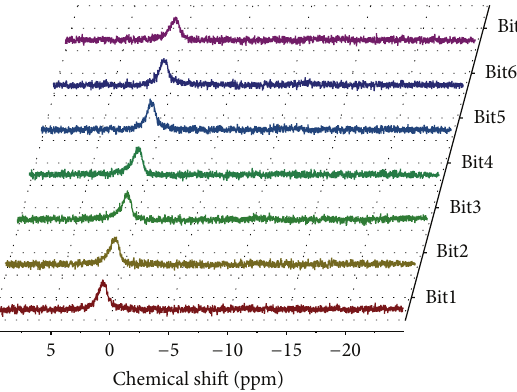
Figure 3: 31 P NMR spectra for PPA-modified bitumen (Bit1–Bit7).